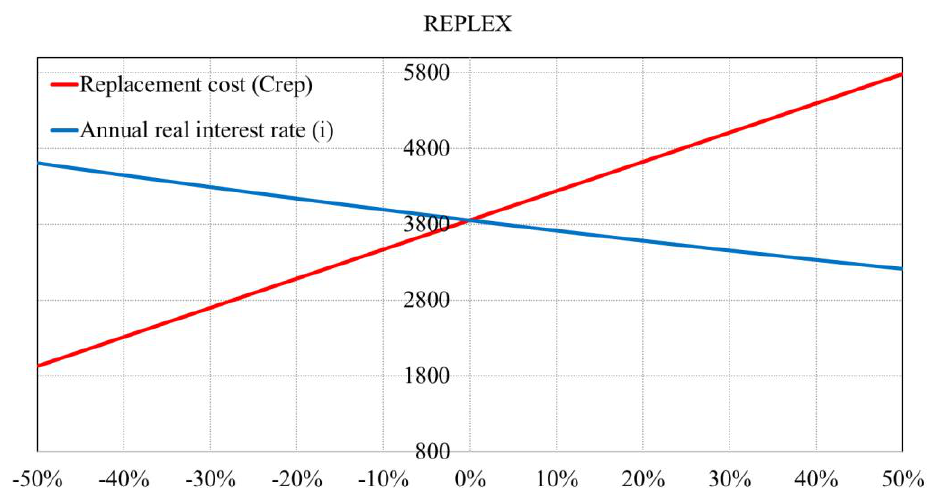
Figure 32. Sensitivity analysis on the REPLEX.